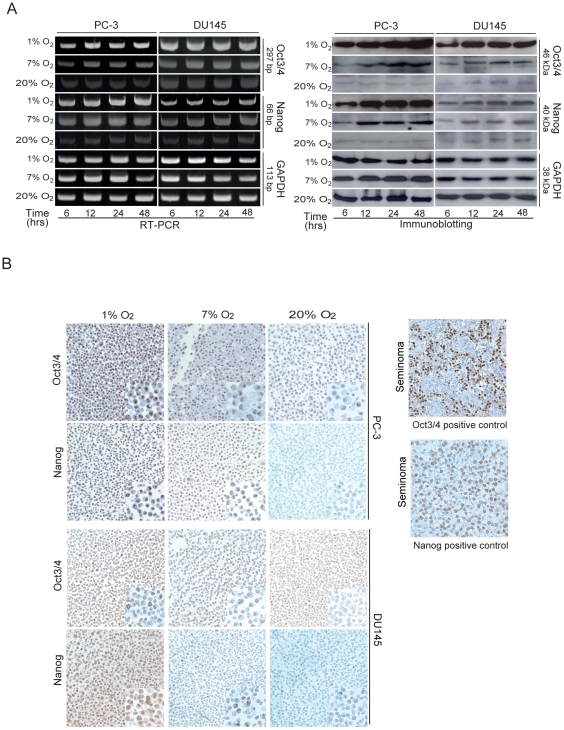
Hypoxia increases the expressions of Oct3/4 and Nanog.(A) In comparison to the cells cultivated at 20% O2, the cells cultivated at 7% O2 show higher levels of Oct3/4 and Nanog expressions, and the cells cultivated at 1% O2 show the highest levels of Oct3/4 and Nanog expressions in PC-3 and DU145 cell lines by both RT-PCR and immunoblotting. (B) Immunocytochemistry reveals corresponding higher levels of Oct3/4 and Nanog expressions at 7% O2 and the highest levels of Oct3/4 and Nanog expressions at 1% O2, in comparison to the cells cultivated at 20% O2 for both cell lines. Human seminoma tissue sections were used as positive controls for these two antibodies. All photos were originally taken at 200× and all the insets were taken at 400×.